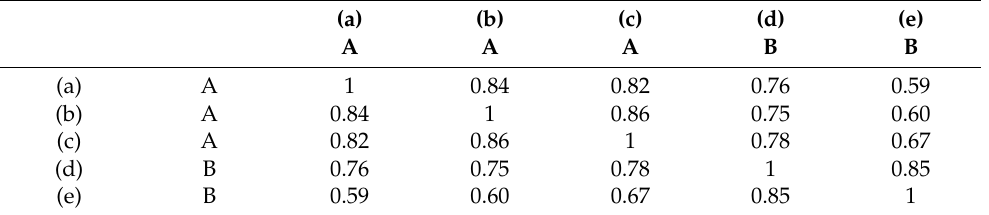
Table 5. Spatial correlation of RSRP. A and B indicate the respective providers under